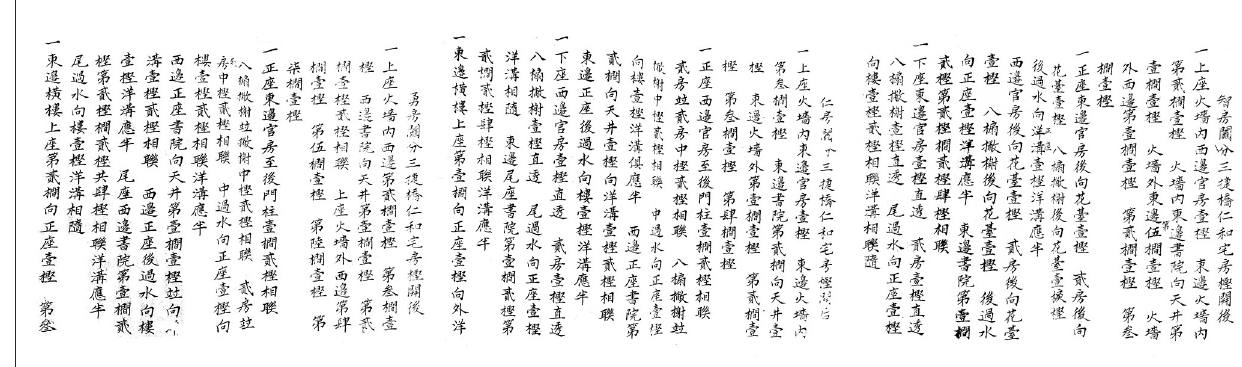
FIGURE3 Jiu Book of Renhe Village.